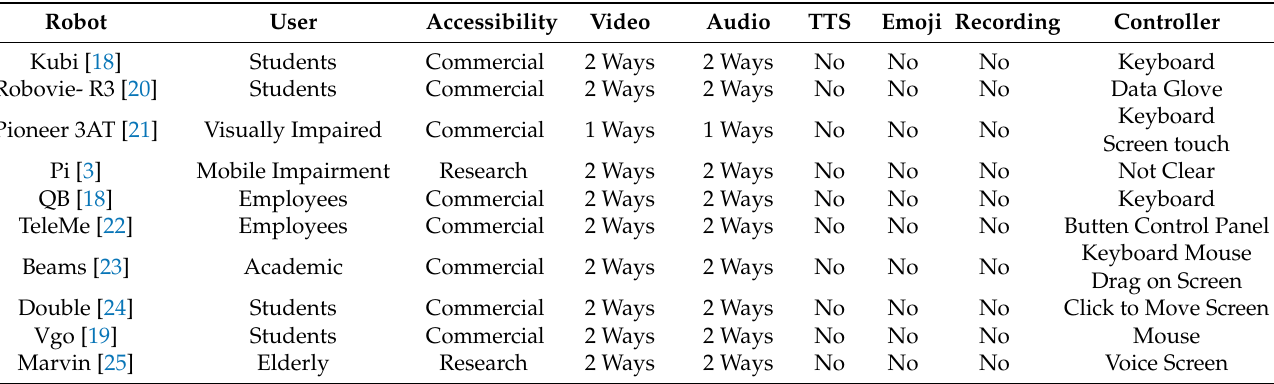
Table 1. Features of the current MRP